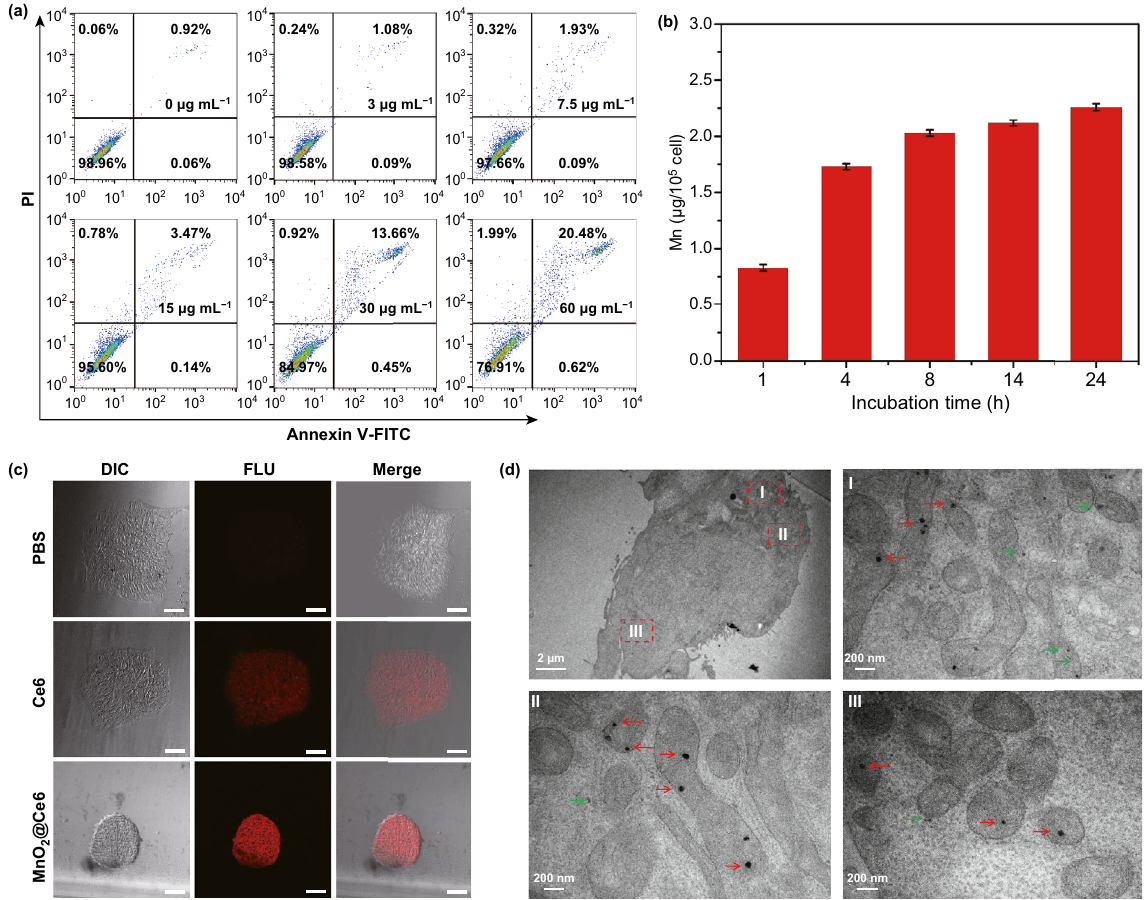
Fig. 2 The loading of nanoprobes by iPS cells. a Flow cytometric analysis of iPS cells apoptosis induced by nanoprobes (Mn concentration: 0-60 μg mL −1 ). b Quantitative cellular uptake of MnO 2 @Ce6 by iPS cells measured by ICP-MS. c Confocal laser scanning microscopy images of iPS cells treated with Ce6 and MnO 2 @Ce6, all scale bars are 100 μm. d Representative TEM images of iPS cells incubated with nanoprobes. In the TEM images, the red arrows indicate the nanoprobe without degradation and the green indicate the nanoprobe with